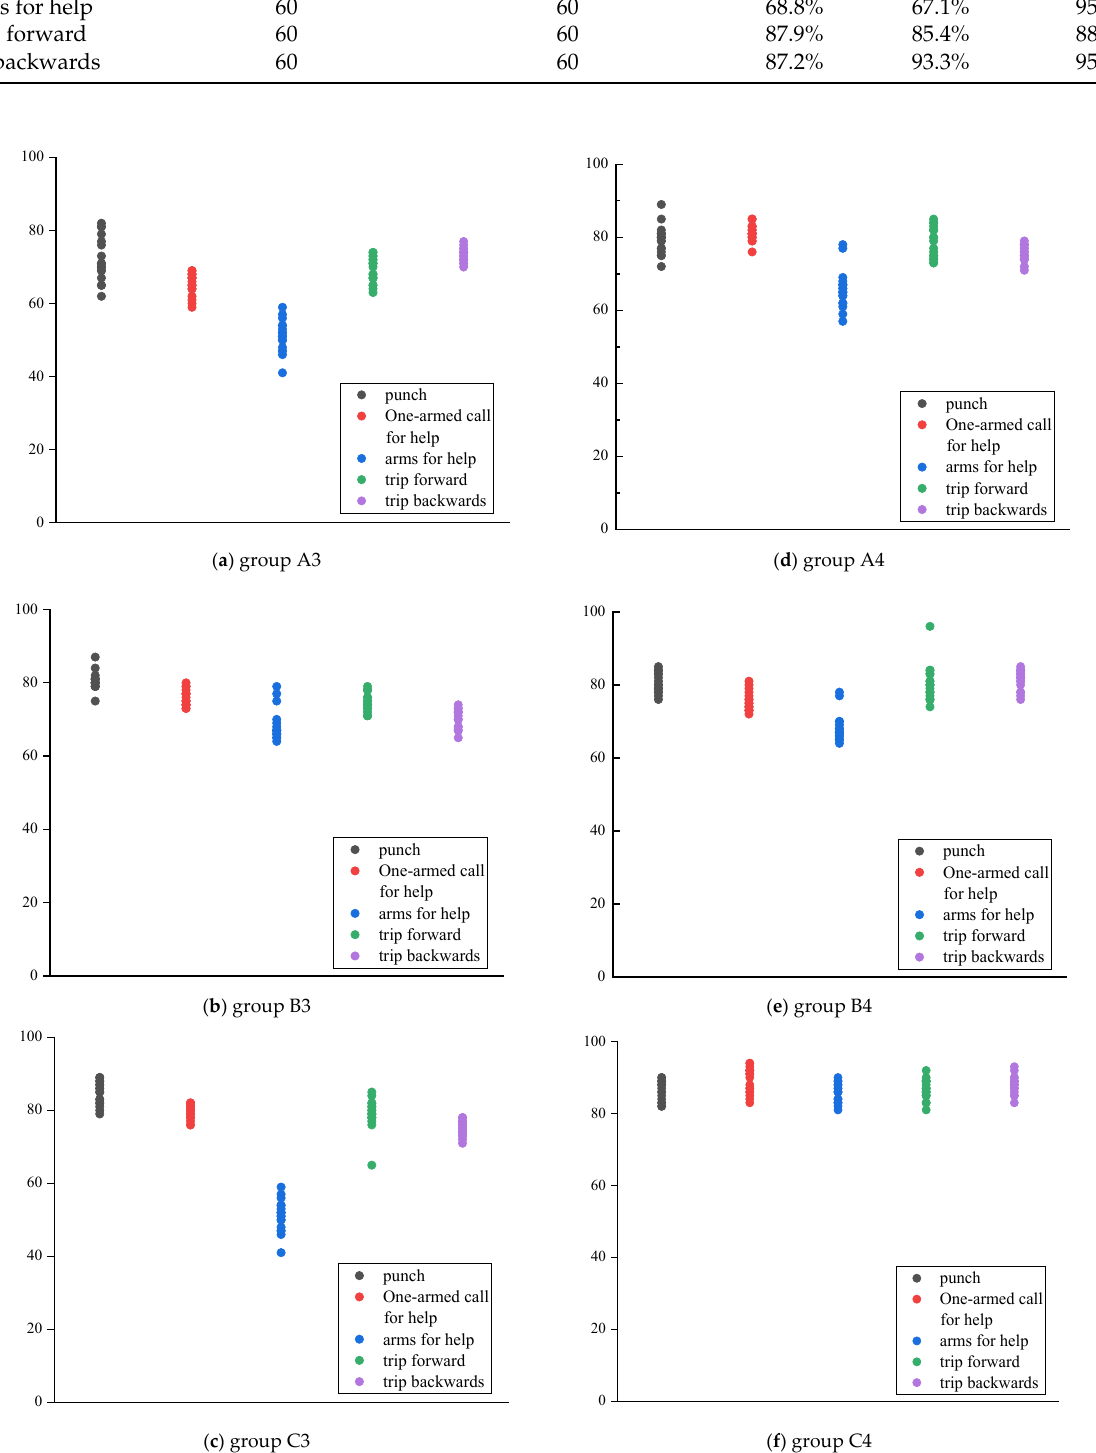
Table 8. Overall “pelvis divergence method” identification results.